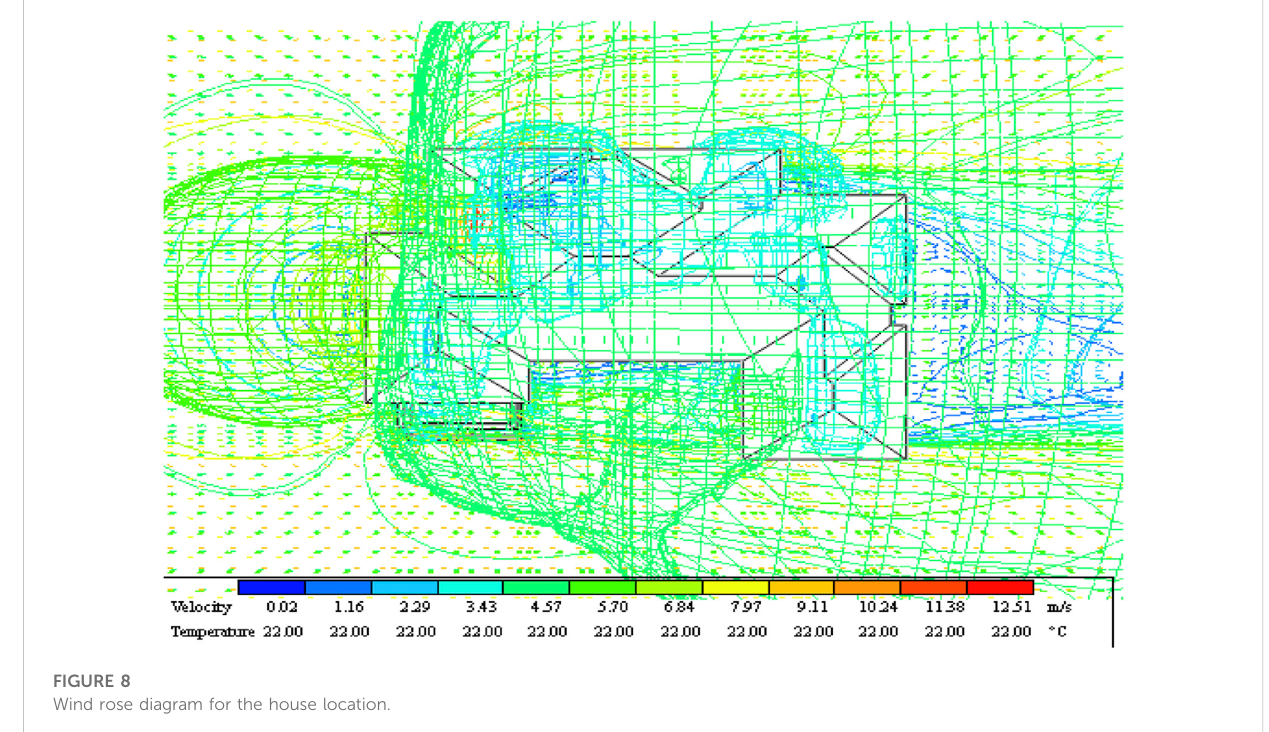
FIGURE 8 Wind rose diagram for the house